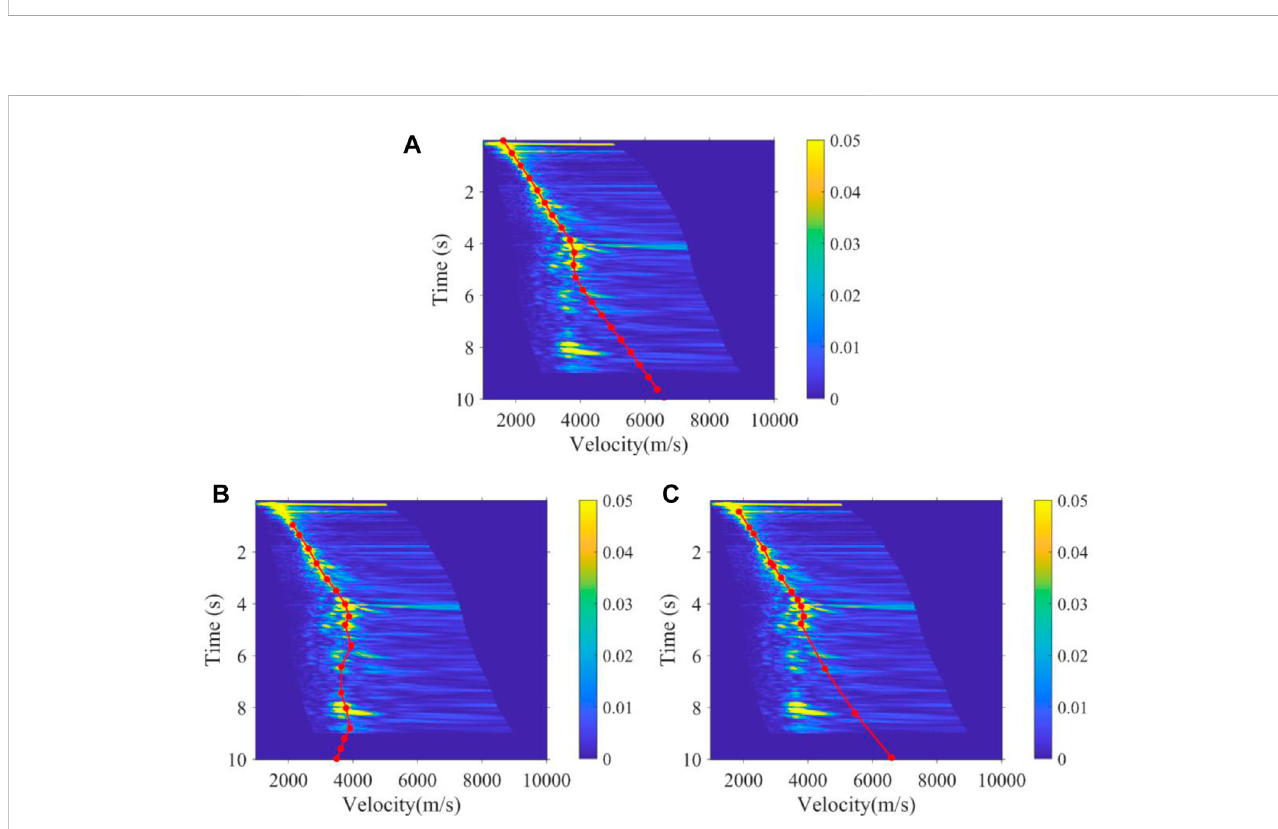
FIGURE 13 Velocity function of the 4300th velocity spectrum obtained by (A) manual, (B) K-means, and (C) the method proposed.